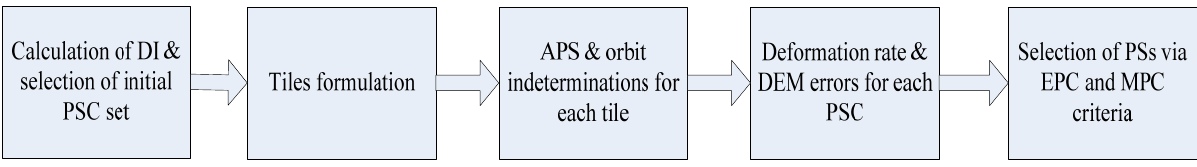
Figure 3. Block diagram illustrating the PerSePHONE algorithm processing